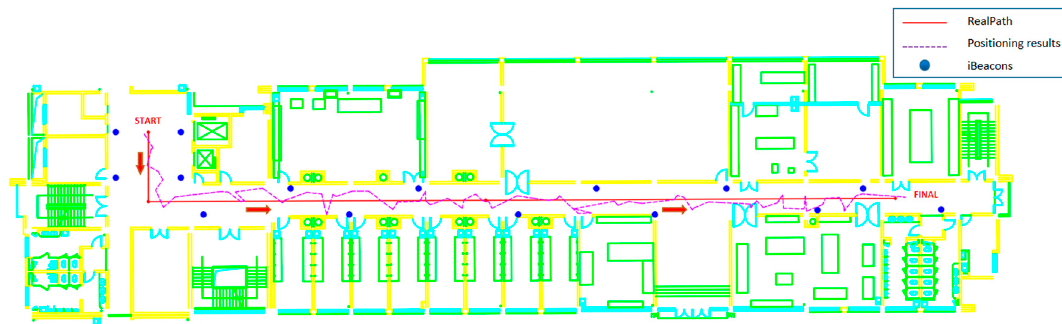
Figure 9. Positioning results. Table 4. Errors in positioning using anomaly detection and weighted LM algorithm.